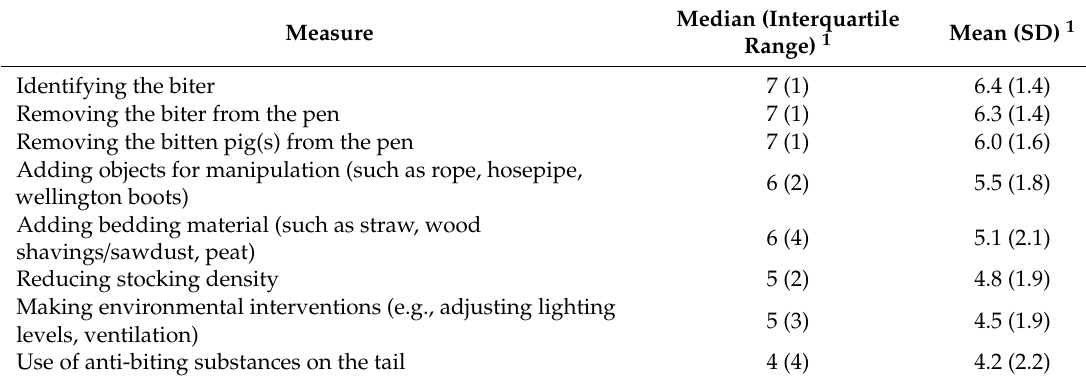
Perceived importance of the di ff erent tail biting intervention measures given in the